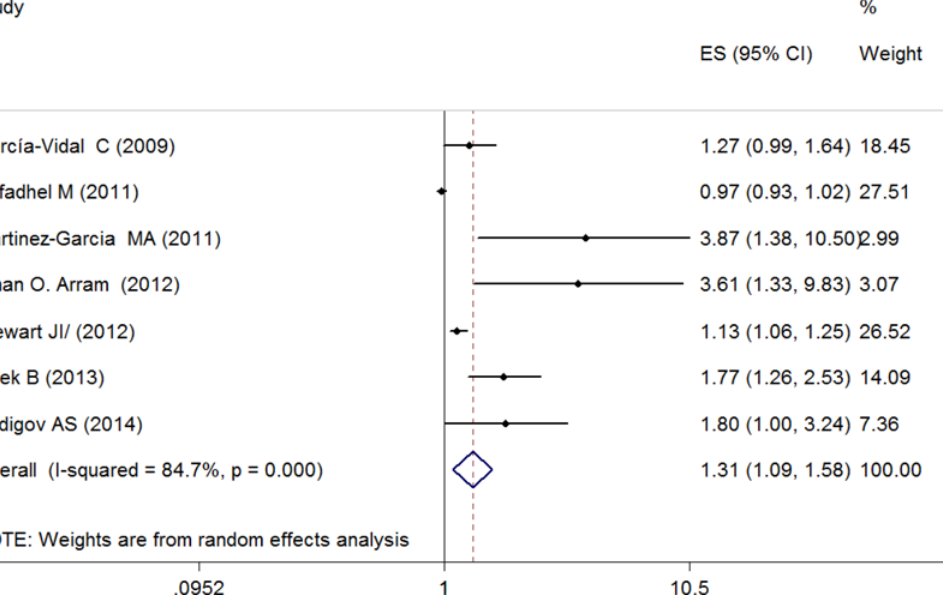
Fig 4. Odd ratios for the association between comorbid bronchiectasis and risk for severe airway obstruction.